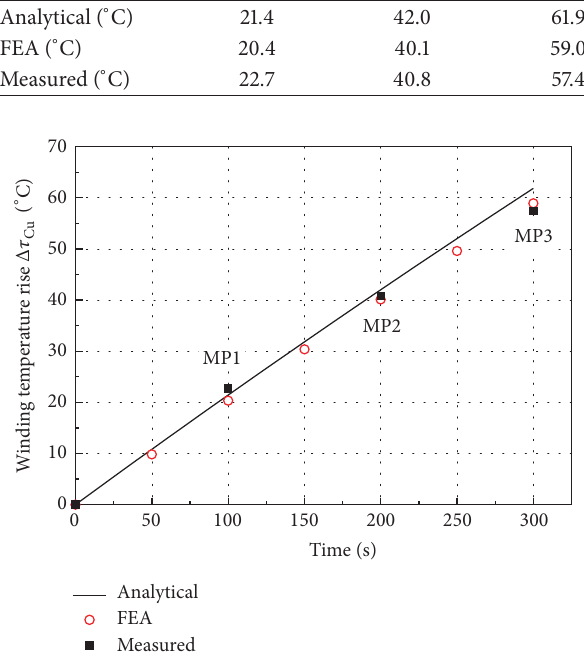
Figure 10: Experimental verification of the winding temperature